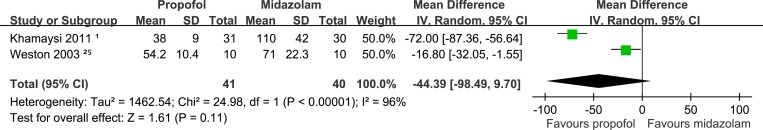
Forest plots of meta-analyses comparing the anesthetic performance of propofol to that of midazolam in RCTs of cirrhotic patients undergoing UGIE.Based on time to discharge.